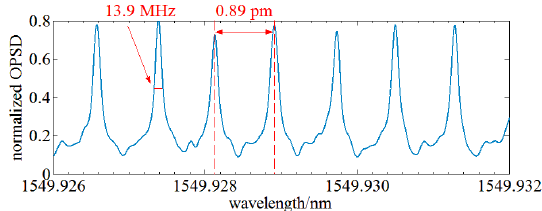
Figure 14. Optical spectrum of an optical frequency comb measured by OENF system.